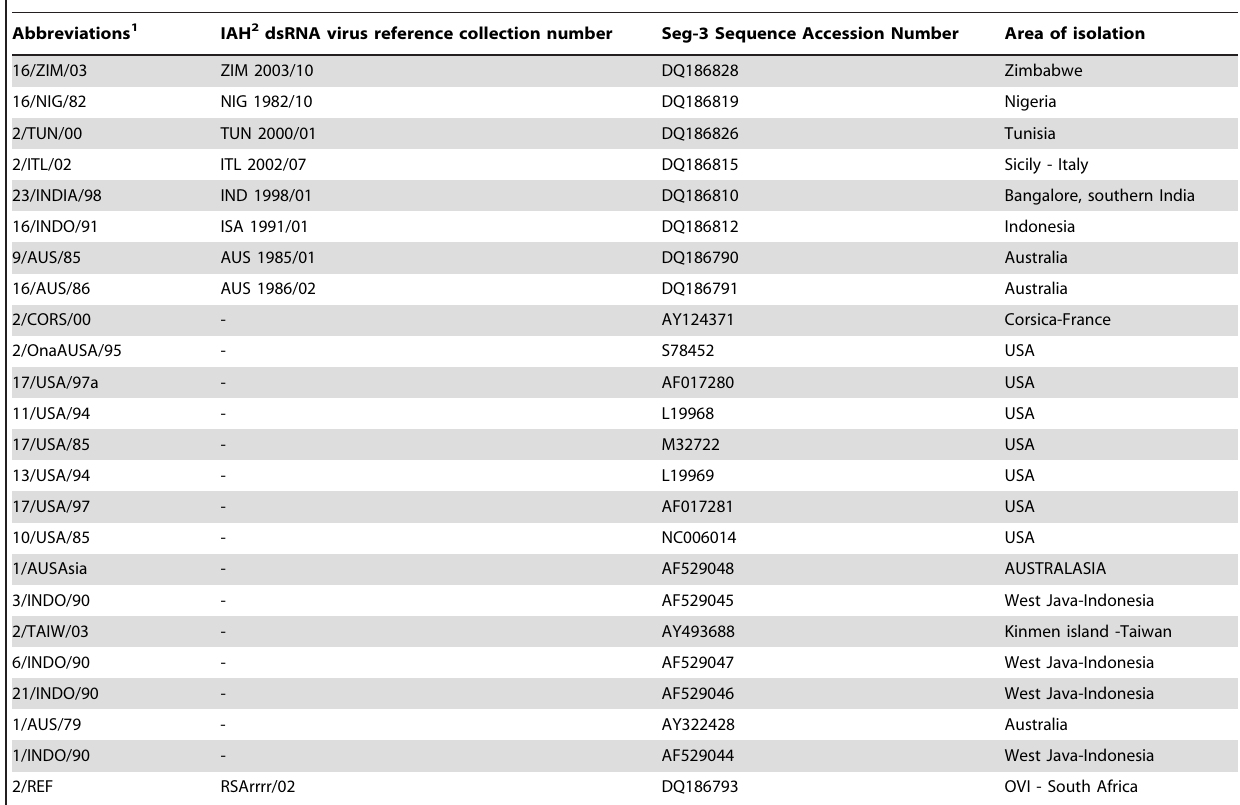
Table 2. BTV isolates and published Seg-3 sequences used for sequence analysis. Further details of the isolates can be